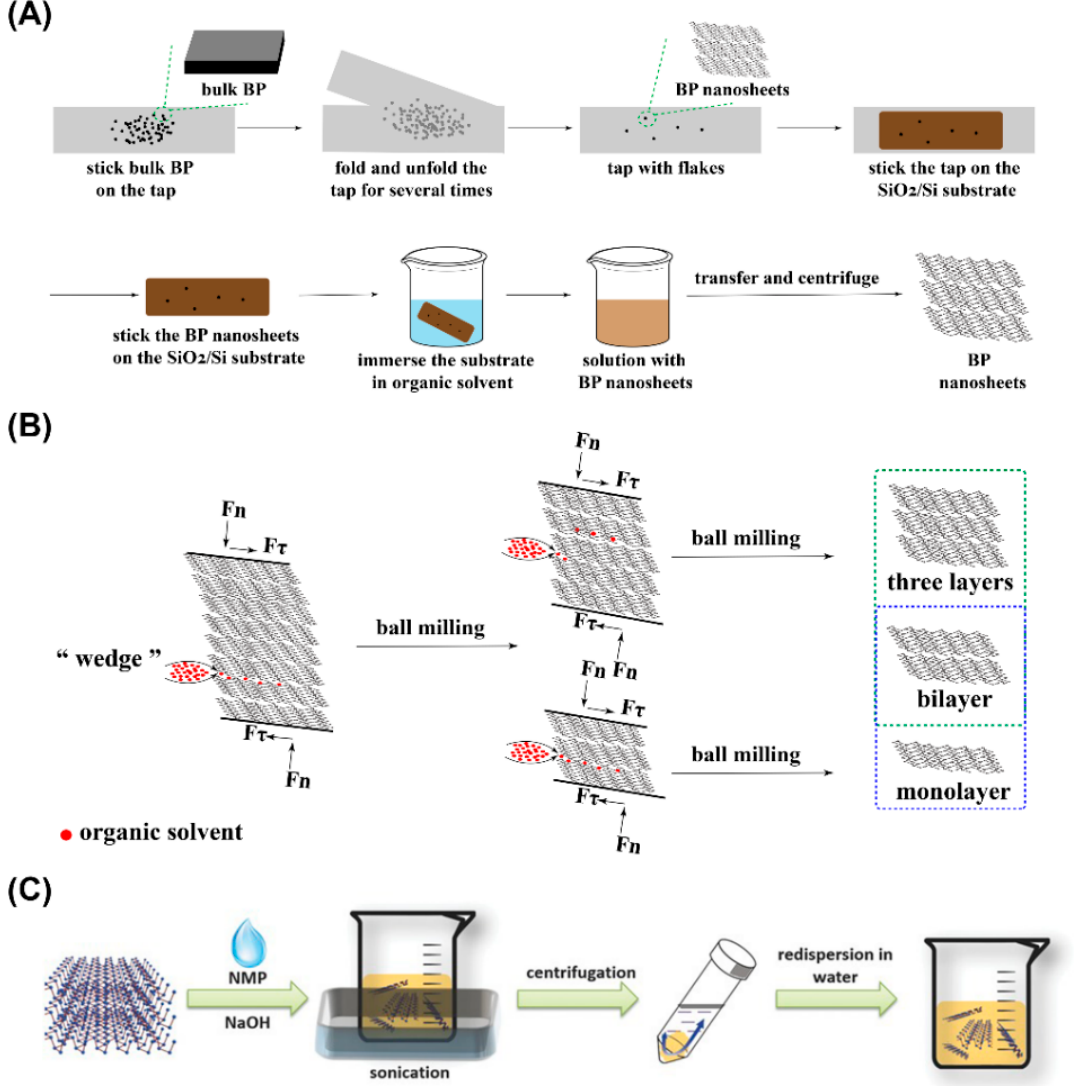
Figure 2. Synthesis routes of BPNSs based on ( A ) tape exfoliation method, ( B ) wet ball milling exfoliation method, and ( C ) ultrasonic-assisted liquid-phase exfoliation method (Reproduced with permission from Guo et al., Adv. Funct. Mater.; published by WILEY, 2015 [48]).